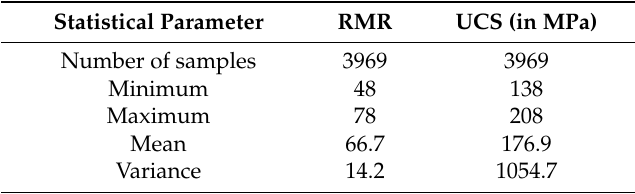
Table 1. Rock Mass Rating (RMR) and UCS (in MPa) statistics for the samples’ values.